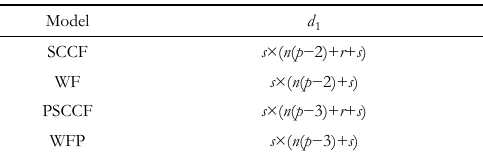
Tests for common features